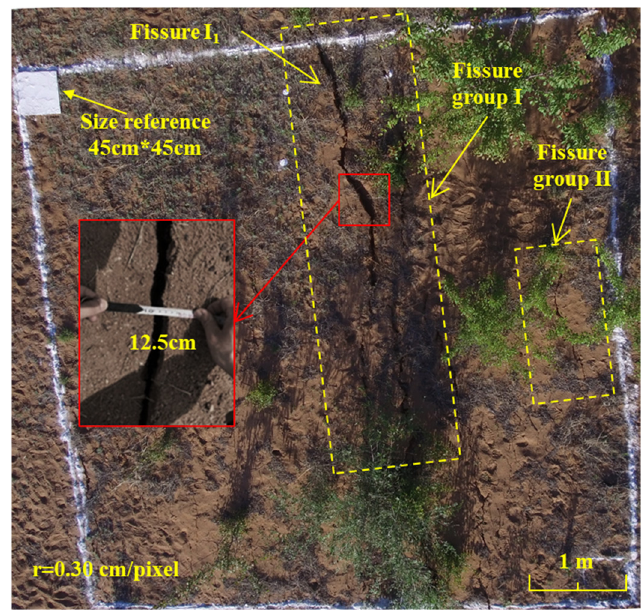
Figure 12. Visible image of the target observation area at 7:00 a.m. Table 4. The Fissure I 1 length in fissure detection results and that in visible image captured at 7:00